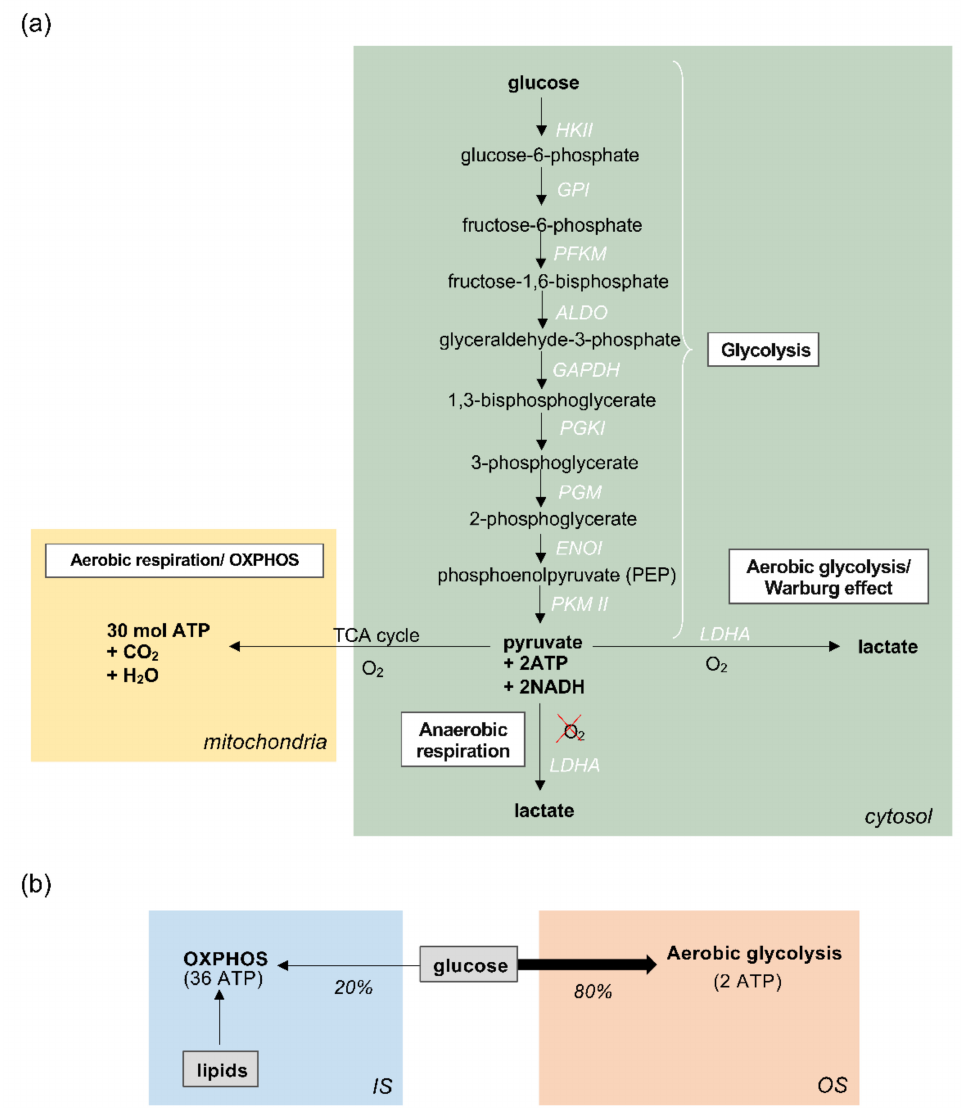
Figure 2. Glucose metabolism in retinal photoreceptors ( a ) Glucose metabolism in photoreceptor cells proceeds first via glycolysis in the cytosol (shown in green), whereby glucose is broken down to produce pyruvate, followed by one of two pathways. In aerobic conditions (oxygen, O 2 ) pyruvate is further metabolised via the TCA cycle and oxidative phosphorylation (OXPHOS) in mitochondria. In anaerobic conditions, when O 2 is absent, pyruvate is converted to lactate by the enzyme Lactate dehydrogenase A (LDHA). In aerobic glycolysis/Warburg effect, the majority of pyruvate is converted into lactate, despite the availability of O 2 for OXPHOS; ( b ) Summary of the metabolic pathways in photoreceptors. 80% of glucose undergoes aerobic glycolysis in the outer segment (OS), where it produces 2 molecules of ATP for every molecule of glucose. The majority of photoreceptor ATP, approximately 36 molecules per 1 glucose molecule, is generated in the inner segment (IS) by oxidative phosphorylation, although this is likely to be predominantly fuelled by lipids rather than